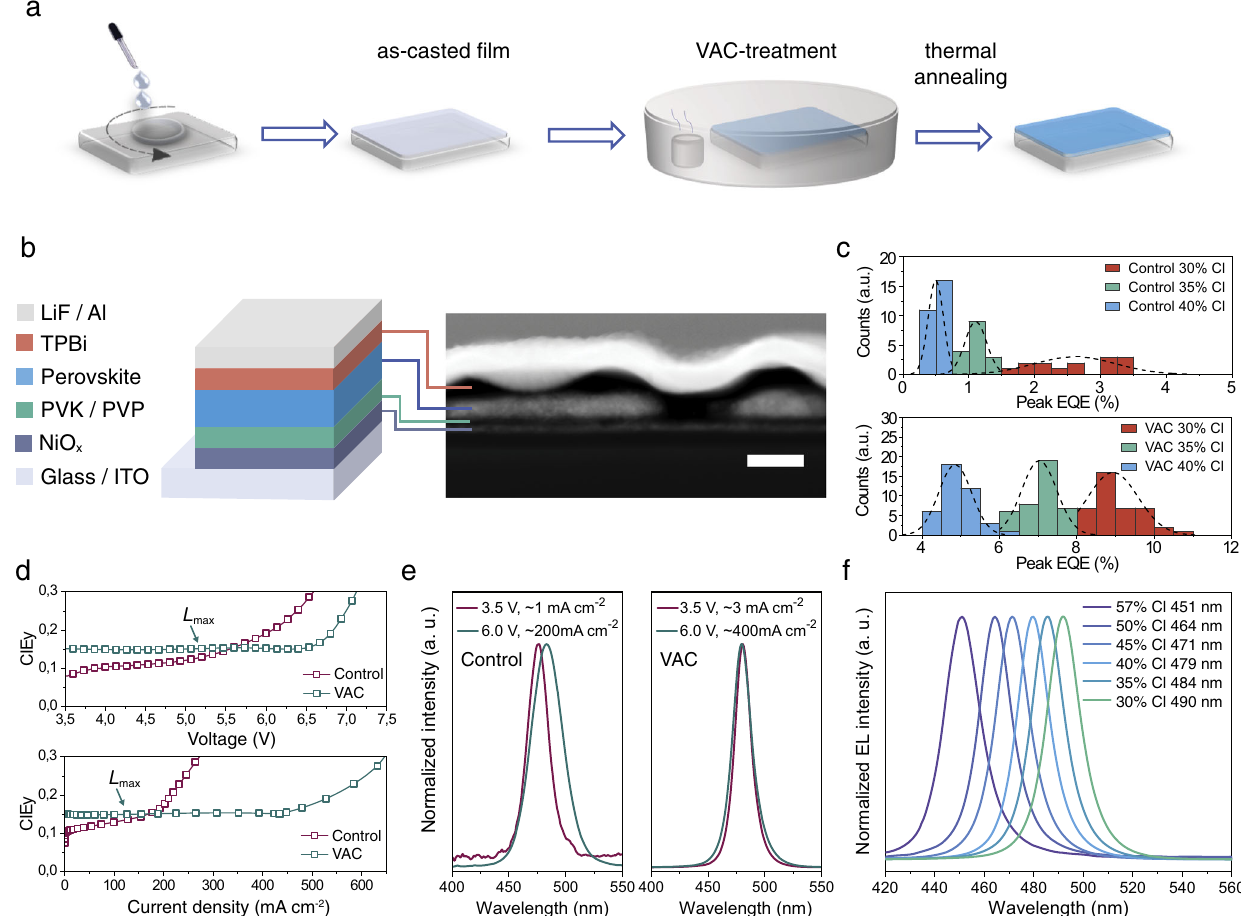
Fig. 1 Device fabrication and characteristics. a An illustration of the VAC-treatment. b Schematic of the PeLED structure and the HAADF cross-sectional device image. The scale bar is 100 nm. c Histograms of peak EQEs extracted from control (top) and VAC-treated devices (bottom) with varying chloride contents (30%, 35% and 40%). d – f Spectral stability for control and VAC-treated devices with 40% Cl loading. The representative plots of CIE y versus applied voltages (top) and current densities (bottom) ( d ); EL spectra at low and high voltage/current density for control (left) and VAC-treated devices (right) ( e ); EL spectra of VAC-treated devices with varying chloride content (30 – 57%) at maximum luminance ( f ). The points labelled as L max in ( d ) represent the operational condition for peak